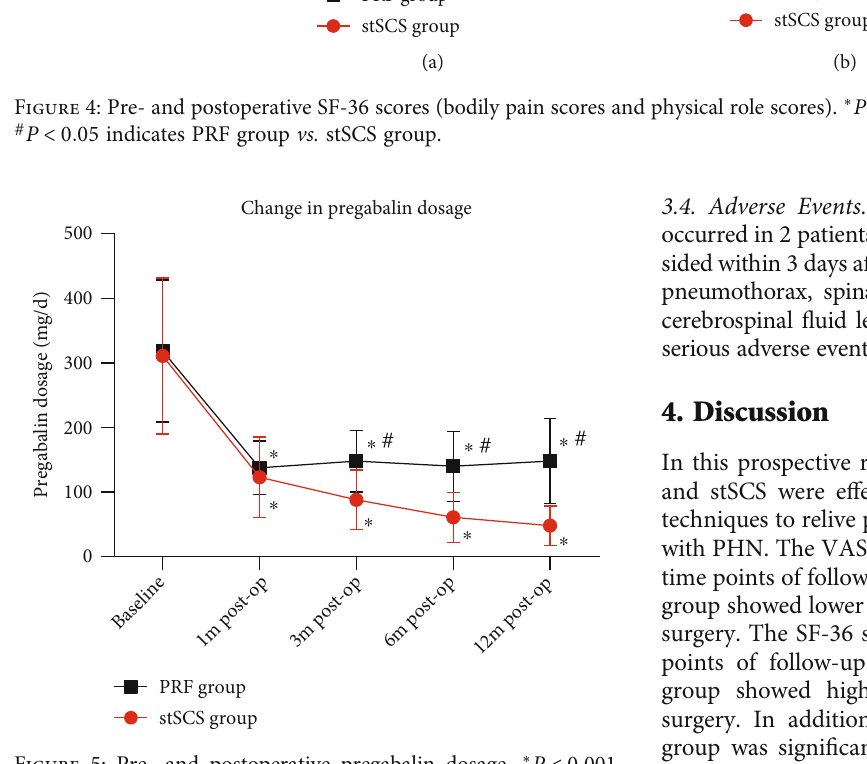
Figure 5: Pre- and postoperative pregabalin dosage. ∗ P < 0 : 001 indicates postoperation vs. baseline. # P < 0 : 05 indicates PRF group vs. stSCS